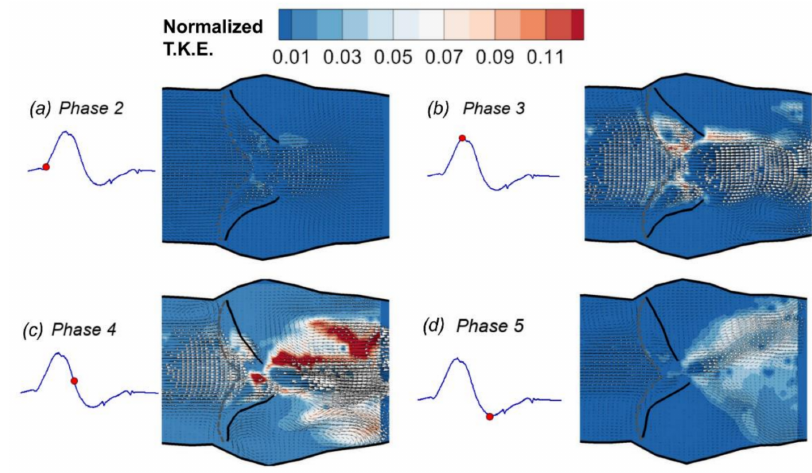
Figure 7. Normalized turbulence kinetic